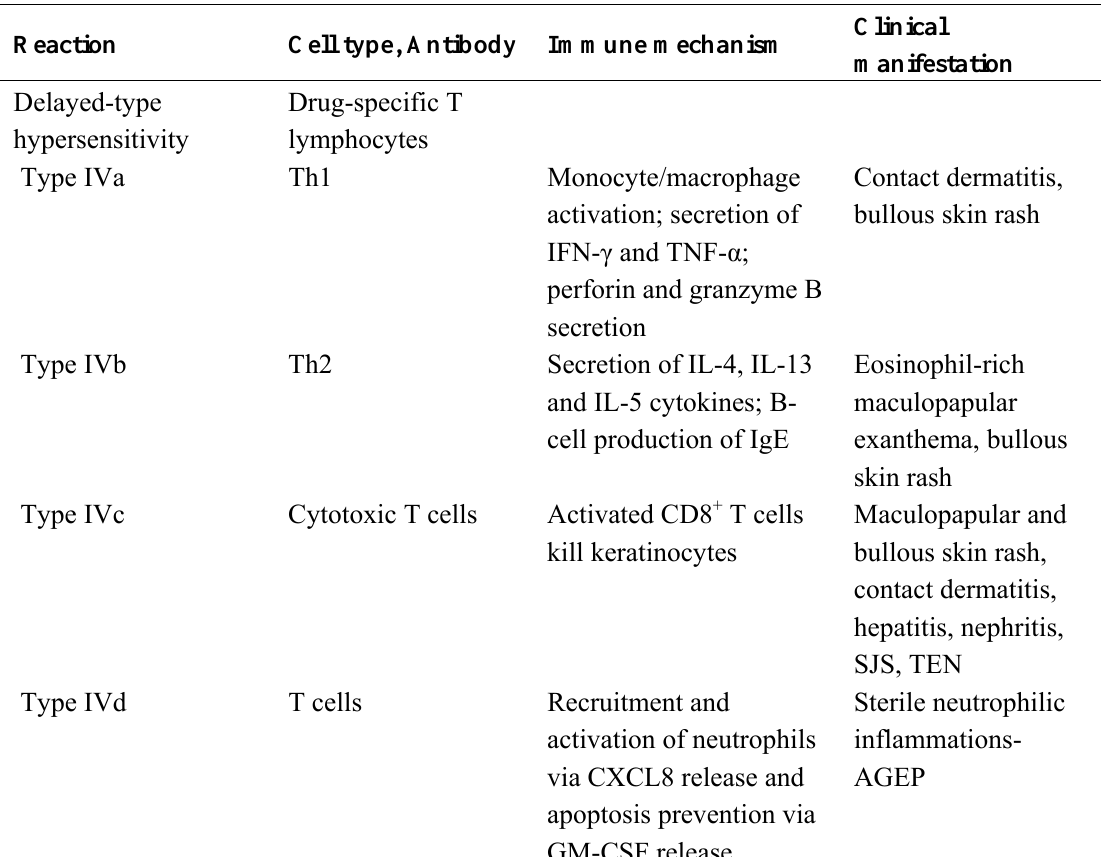
Table 1 . Clinical classification of delayed-type hypersensitivity reactions (adapted from Posadas and Pichler; Torres et al. )